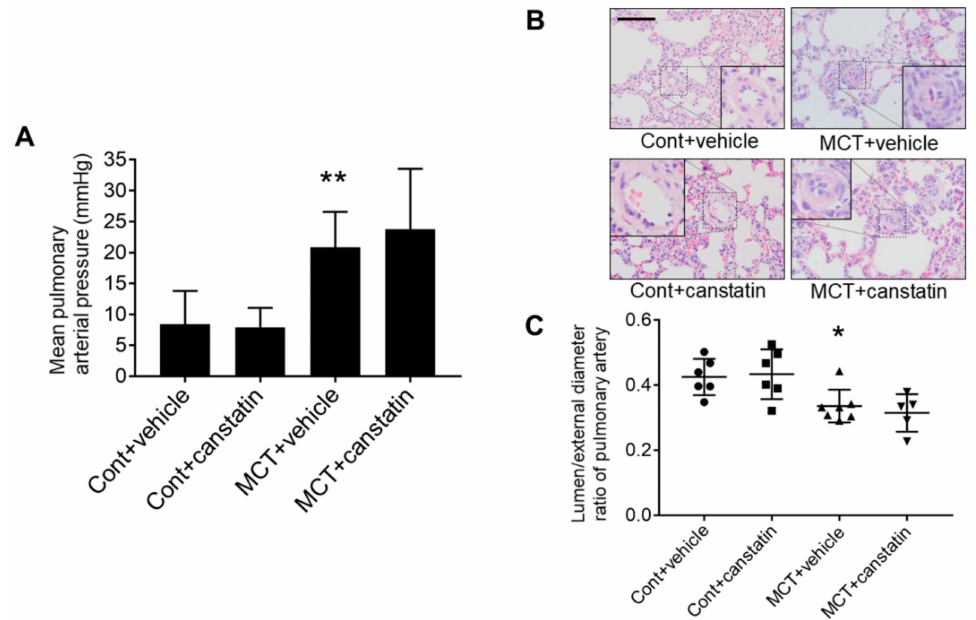
Figure 3. Canstatin had no e ff ect on monocrotaline-induced PAH. Four-week-old male Wistar rats were intraperitoneally injected with saline (Cont) or monocrotaline (60 mg / kg, MCT). Then, vehicle or recombinant mouse canstatin (20 µ g / kg) was intraperitoneally administered to the rats for 3 weeks. ( A ) PA pressure was measured by right ventricular catheterization. Mean PA pressure was shown as mean ± S.E.M. (Cont + vehicle: n = 7, Cont + canstatin: n = 8, MCT + vehicle: n = 6, MCT + canstatin: n = 5). ( B , C ) The lung was isolated and thin para ffi n section was made. ( B ) Representative hematoxylin and eosin (HE) stained pictures of the lung from Cont + vehicle, Cont + canstatin, MCT + vehicle and MCT + canstatin are shown. Scale bar: 100 µ m. ( C ) Luminal / external diameter ratio (in%) of PA (outer diameter: 30–50 µ m) was calculated and is shown as scatter plots of individual data points and mean ± S.E.M. (Cont + vehicle: n = 6, Cont + canstatin: n = 6, MCT + vehicle: n = 7, MCT + canstatin: n = 5). *, ** p < 0.05, 0.01 vs. Cont +